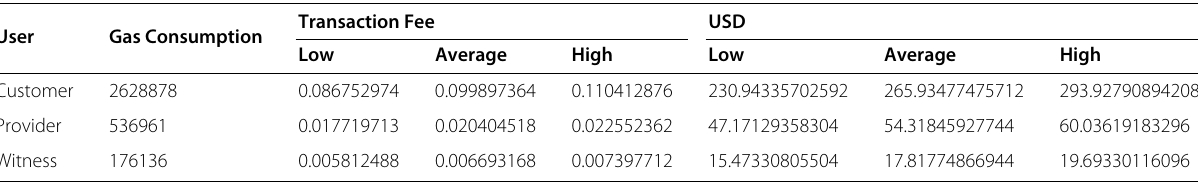
Table 3 The transaction fee of each AWESOME user in a specific auction